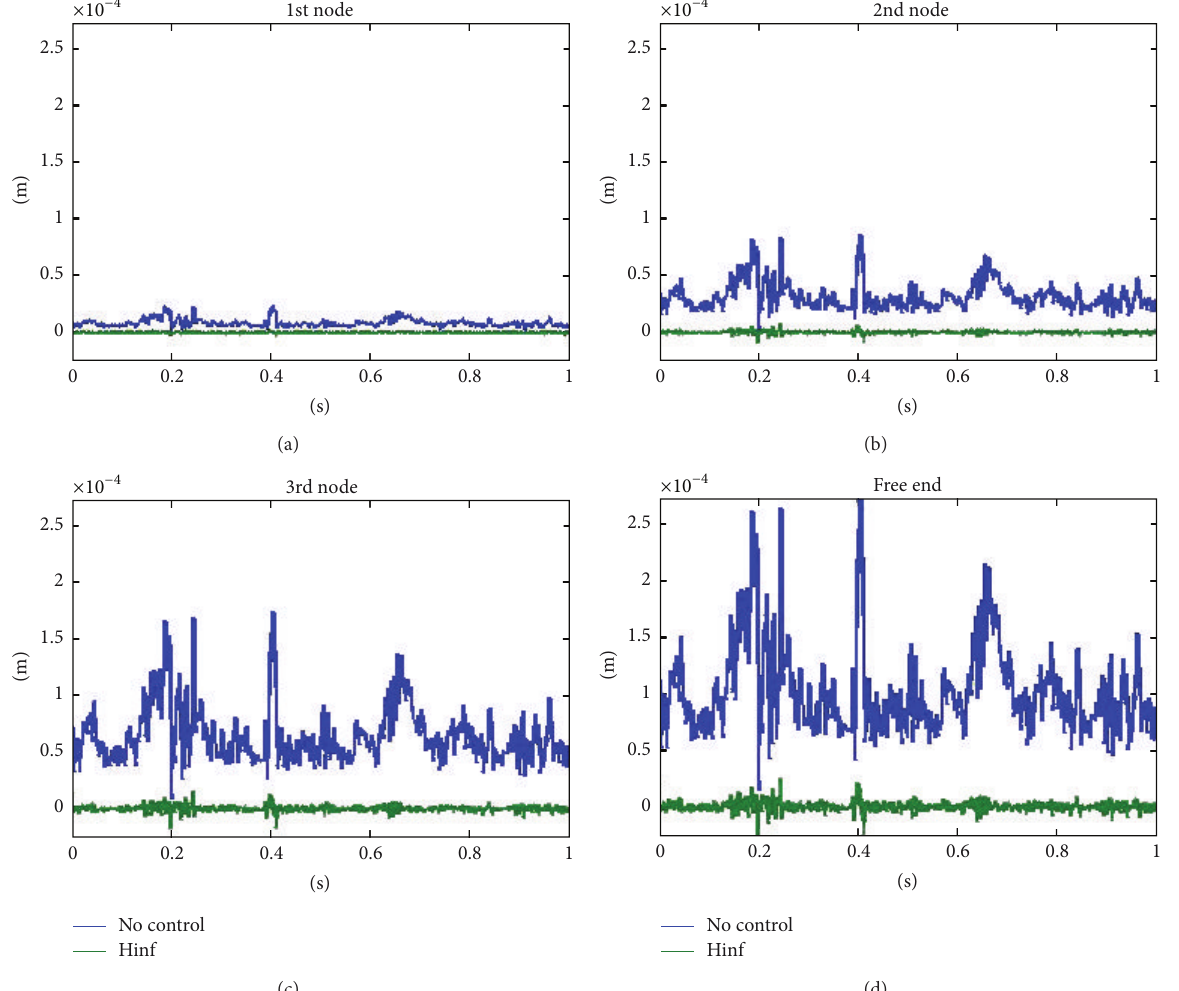
Figure 15: Displacement at all beam nodal points, with and without 𝐻 ∞